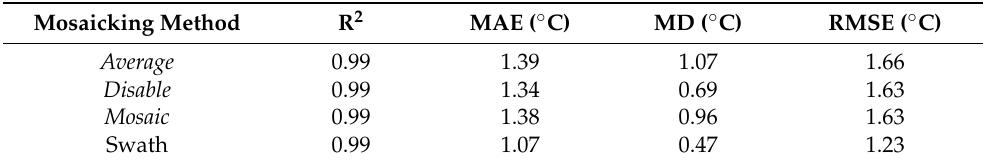
Table 3. Evaluation of Agisoft PhotoScan blending modes and the novel swath-based correction method against in situ Apogee measurements. Coefficient of determination (R 2 ), root mean square error (RMSE), mean difference (MD), and mean absolute error (MAE) are reported for the four mosaicking methods based on 12 UAV flight surveys and four Apogee sensors ( n = 48). Mosaicking